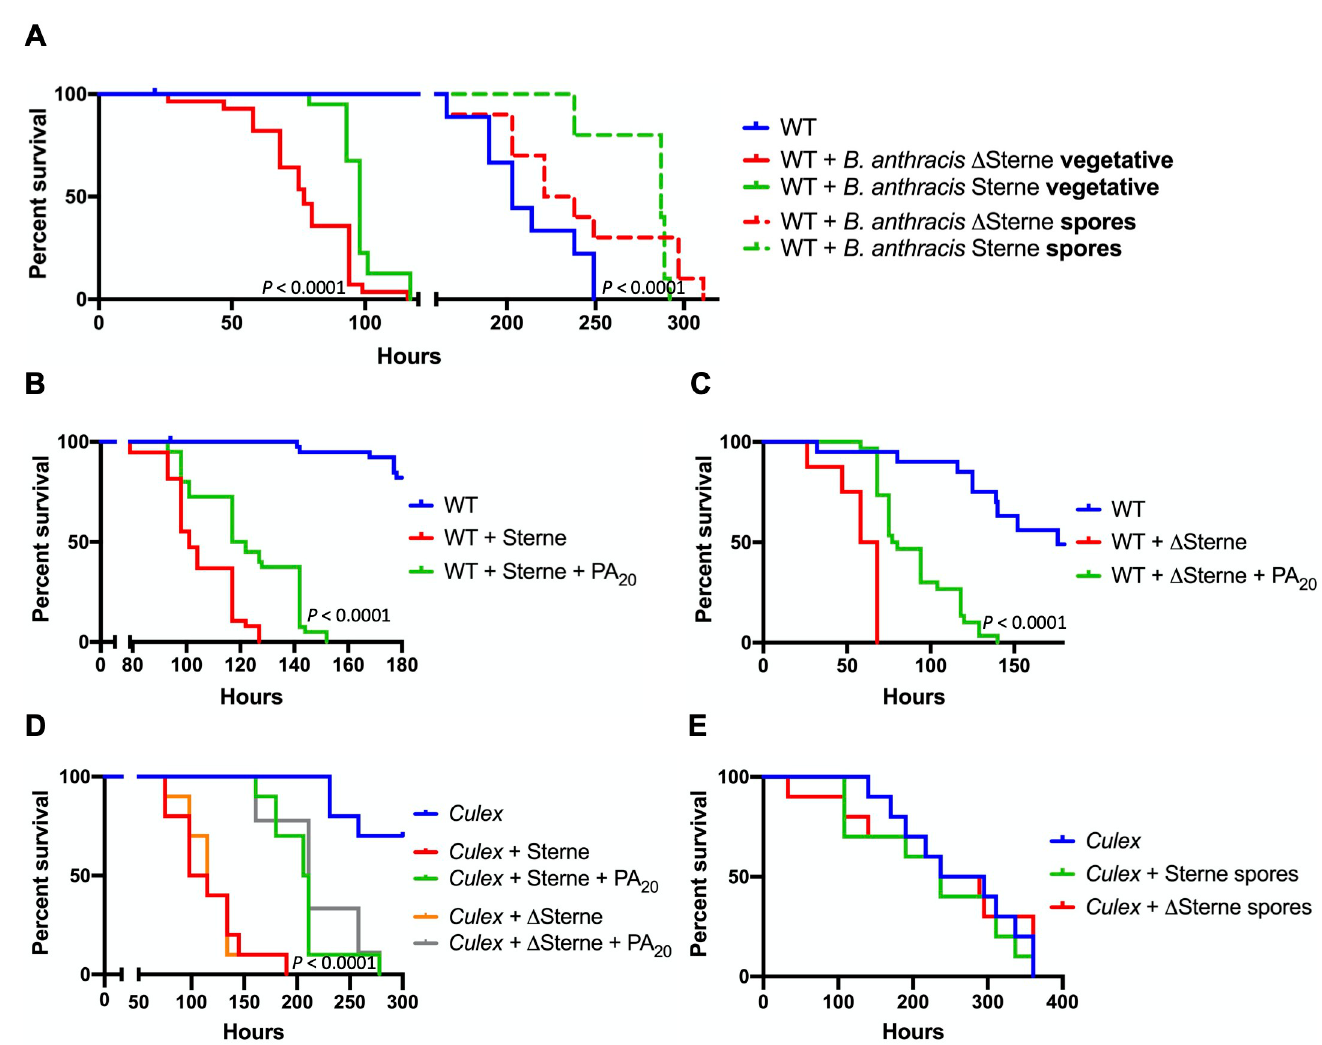
Fig 3. PA 20 protects Drosophila from Bacillus anthracis . (A) WT flies were orally challenged with B . anthracis Sterne and plasmid-cured Δ Sterne strains in vegetative and spore states. P values in (A) indicate the statistical significance of Sterne vs. Δ Sterne for vegetative and spore states. (B-C) WT flies were orally challenged with vegetative cells of the B . anthracis Sterne (B) and Δ Sterne (C) strains with or without PA 20 . P as in Fig 1. (D) Male Culex quinquefasciatus ( Culex ) were orally challenged with vegetative B . anthracis Sterne or Δ Sterne strains with or without PA 20 . P as in Fig 1. (E) C . quinquefasciatus ( Culex ) mosquitoes were orally challenged with spores of B . anthracis Sterne or Δ Sterne